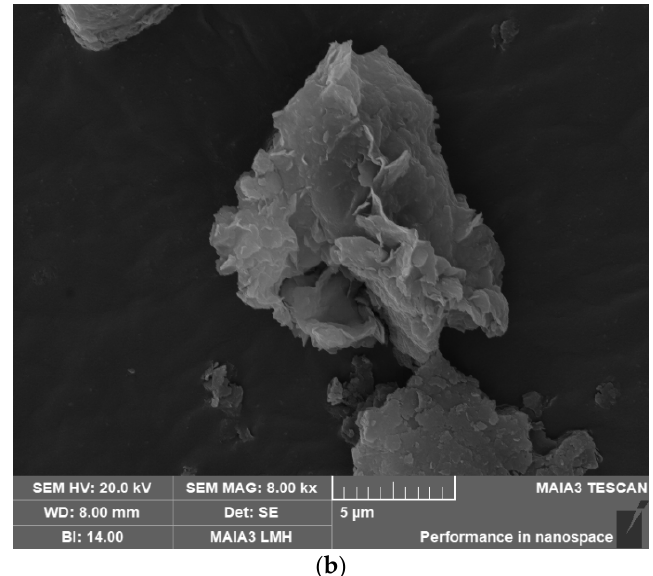
Figure 7. The SEM of NA ( a ) and NAD – Zn ( b ).